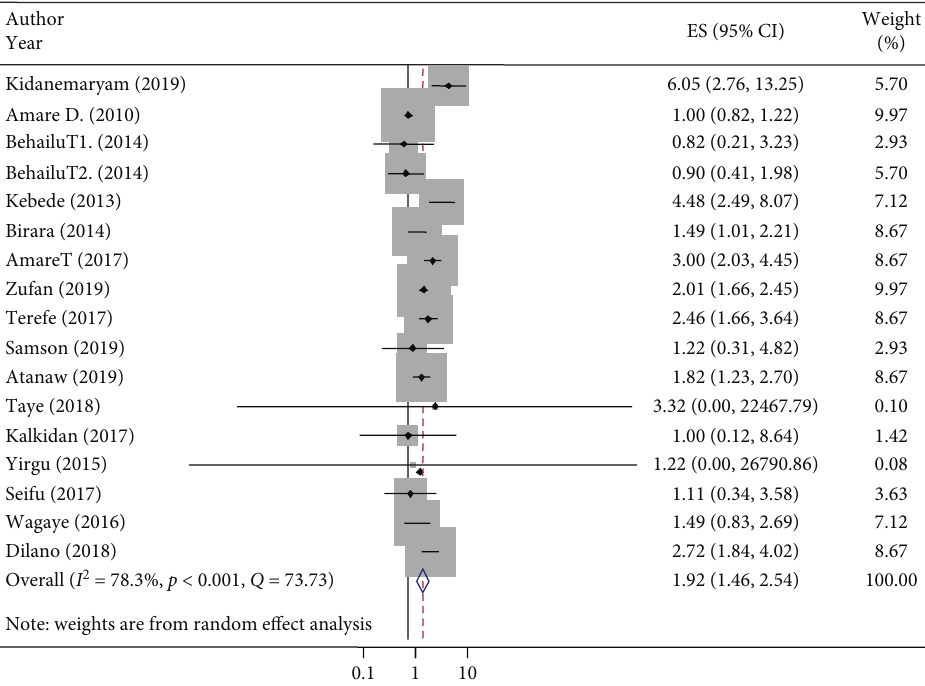
0.1 Figure 5: The pooled associations of stunting and poor household wealth index in